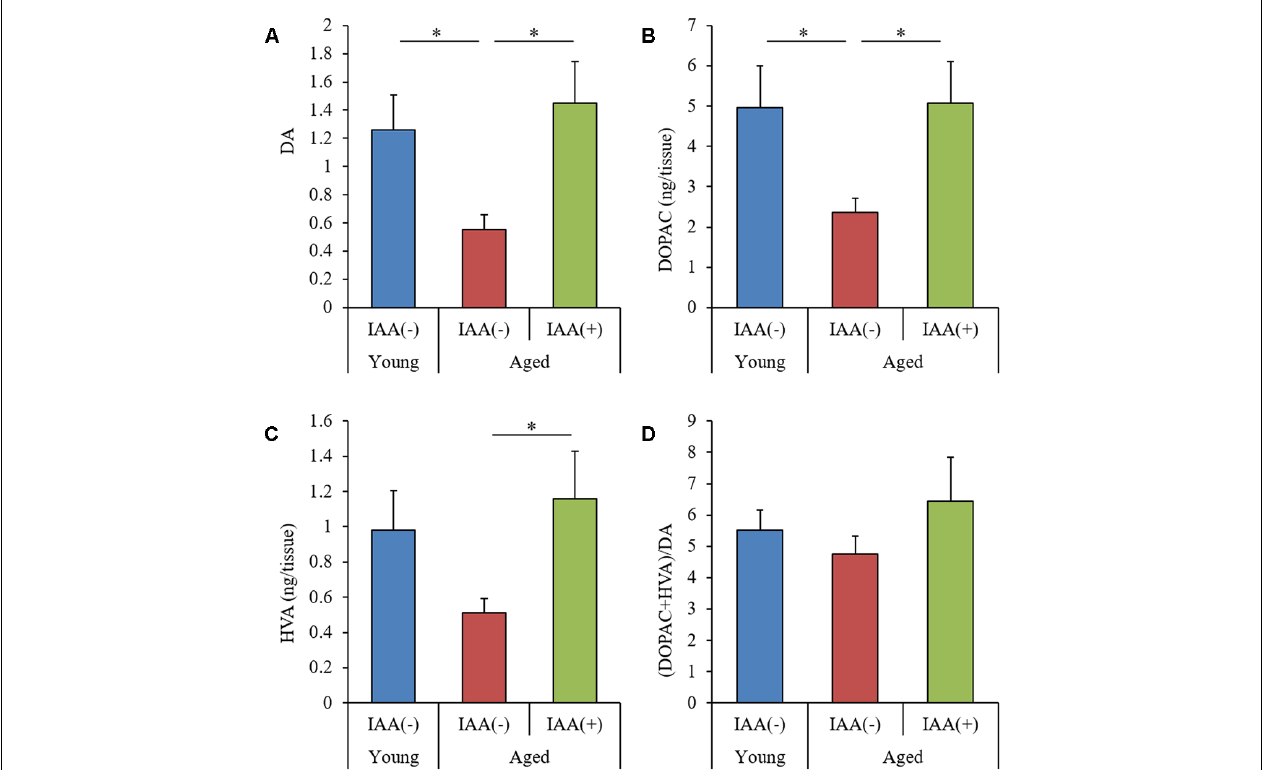
FIGURE 4 | Levels of dopamine (DA) and its metabolites in aged mice. We fed C57BL/6J mice aged 7 weeks (young) and 68 weeks (aged) diets containing 0% or 0.05% (w/w) IAA for 3 months and then obtained brain tissue for analysis of monoamine content in young mice ( n = 12) and aged mice with ( n = 10) or without ( n = 9) dietary IAA. (A–C) The amount of DA (A) , 3, 4-dihydroxyphenylacetic acid (DOPAC; B ), and homovanillic acid (HVA; C ) in the hippocampus. (D) The ratio of (DOPAC + HVA)/DA. Data are presented as mean ± SE. We calculated the p -values shown in the graph by one-way ANOVA, followed by the Tukey-Kramer test. ∗ p <